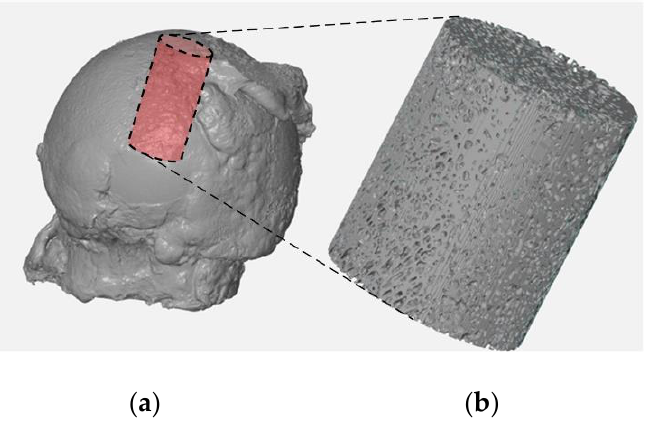
Figure 1. Micro-CT reconstruction of the femoral head specimen ( a ) and the digitally extracted cylinder-shaped bone sample ( b ) for further micro-CT evaluation of bone trabecular microarchitecture and density.